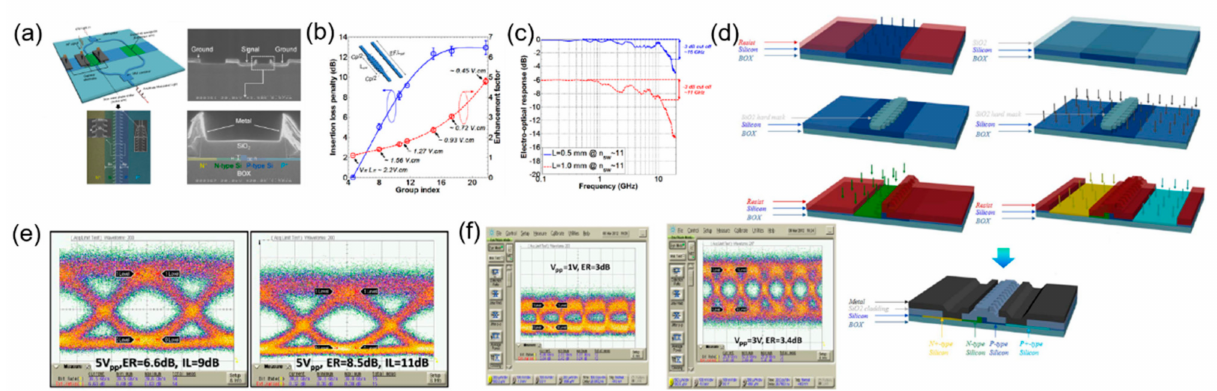
Figure 12. The structure and performance of silicon waveguide grating modulator. ( a ) Schematic and SEM of silicon waveguide grating modulator [64]. ( b ) The relationship between modulation efficiency and group index of the slow-light modulator [64]. ( c ) EO response of two modulators with slow-light phase-shifter lengths of 0.5 mm and 1 mm [64]. ( d ) CMOS fabrication process for the silicon waveguide grating modulator [66]. ( e ) Eye diagram of 40 Gb/s for 500 µ m device [65]. ( f ) Eye diagram of 5 Gb/s and 25 Gb/s for 1 mm device at low drive voltage [66].